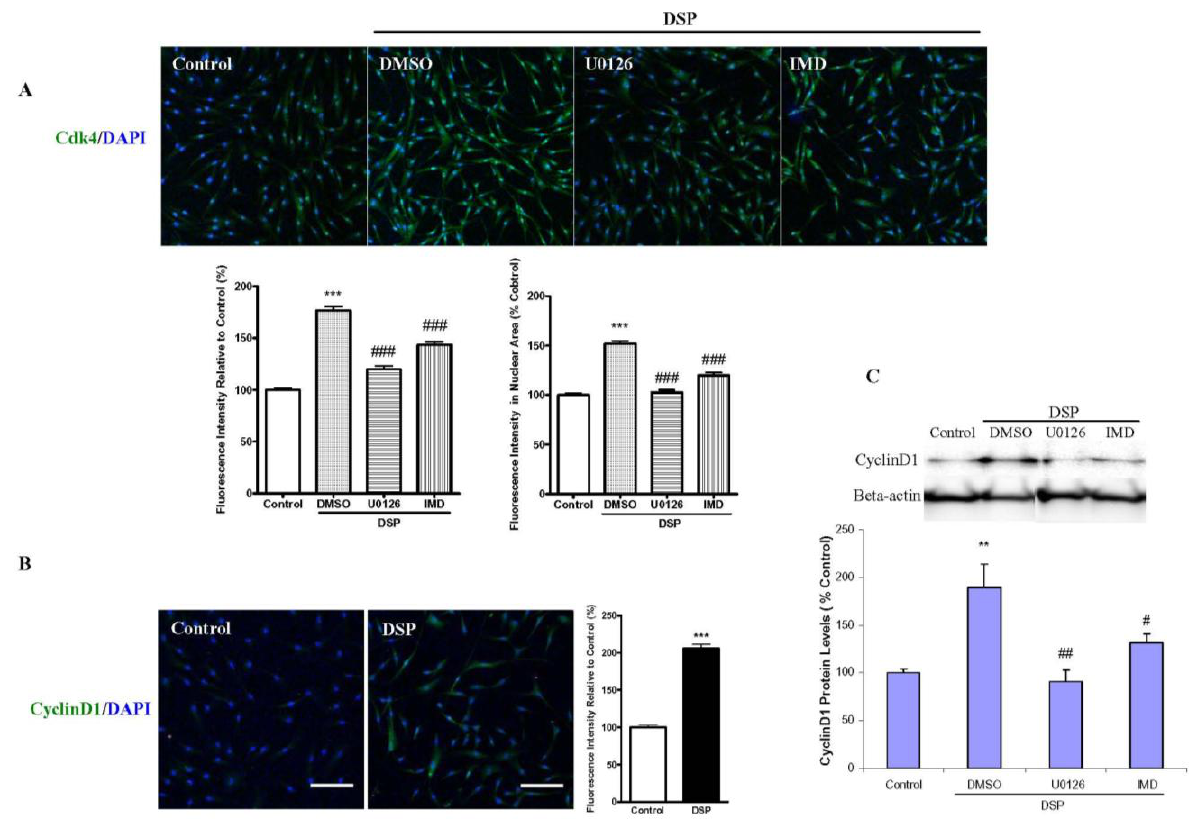
FIGURE 3. DSPs increase cyclinD1 and cdk4 expression through activation of ERK and NF-κB in human VSMCs. Serum-starved cells were treated with 0.2 μl/ml of DSPs for 24 h. 10 μM of U0126 or 30 nM of IMD-0354 were added to cells 30 min prior to treatment with DSPs. (A) Bar graphs show the effects of inhibitors on DSP-induced expression of cdk4 in whole cell (the left graph) and in nuclear area (the right graph). The upper panels indicate representative images of immunofluorescence for cdk4 (green) and nuclear DAPI staining (blue). The scale bar in each image represents 20 μm. (B) Bar graphs show the results of statistical analysis of the fluorescence intensities for the expression of cyclinD1. The left panels indicate representative images of immunofluorescence for cyclinD1 (green) and nuclear DAPI staining (blue). The scale bar in each image represents 20 μm. (C) Bar graphs show the effects of inhibitors on DSP-induced expression of cyclinD1. The upper panels indicate representative autoradiographs of western blot. Data represent mean ± S.E.M. ** p < 0.01, *** p < 0.001 vs. control; # p < 0.05, ## p < 0.01, ### p <0.001 vs. DMSO; IMD =